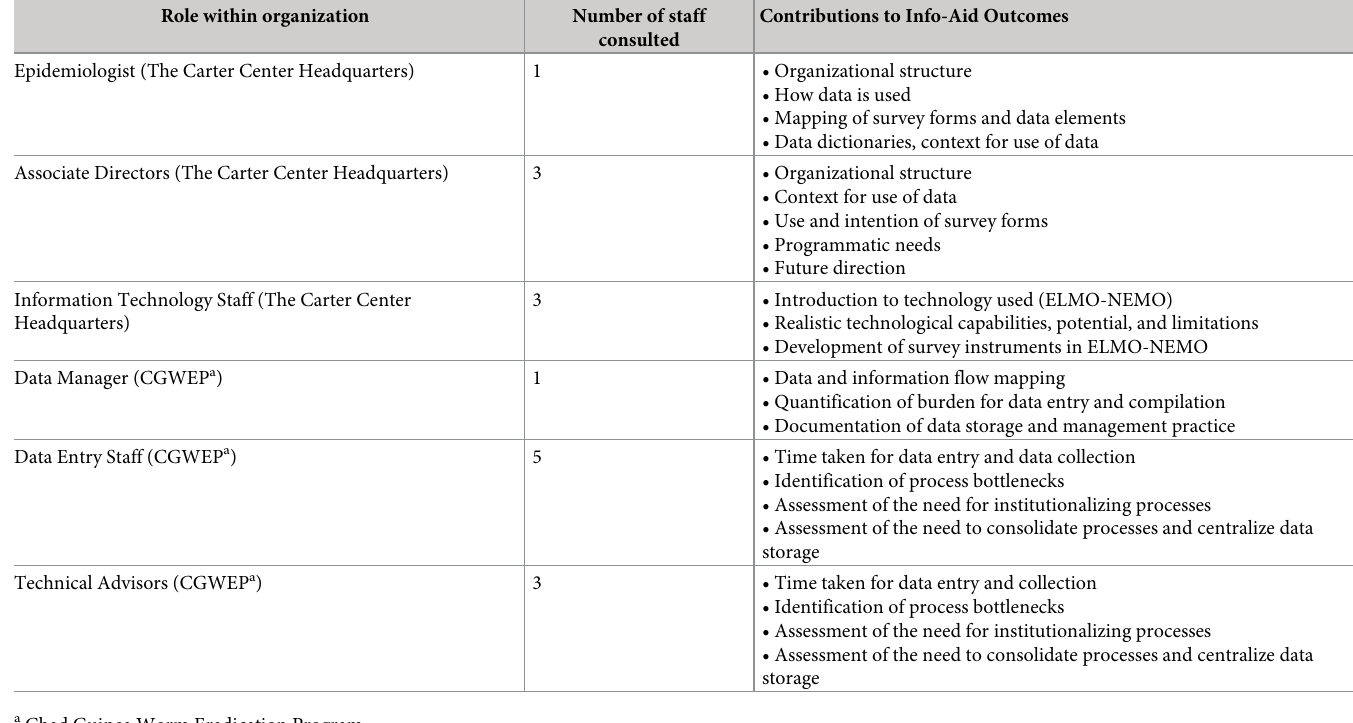
Table 1. Description of roles of staff consulted and contributions to Info-Aid outcomes. Role within